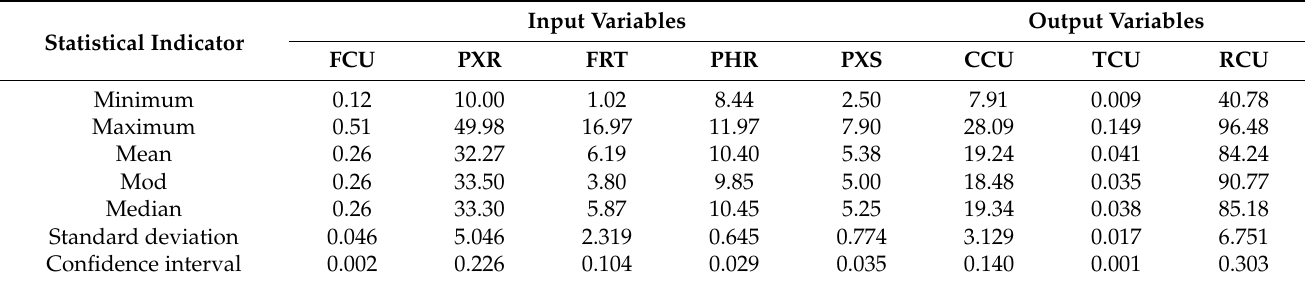
Table 4. Statistical indicators of the input and output variables in the flotation